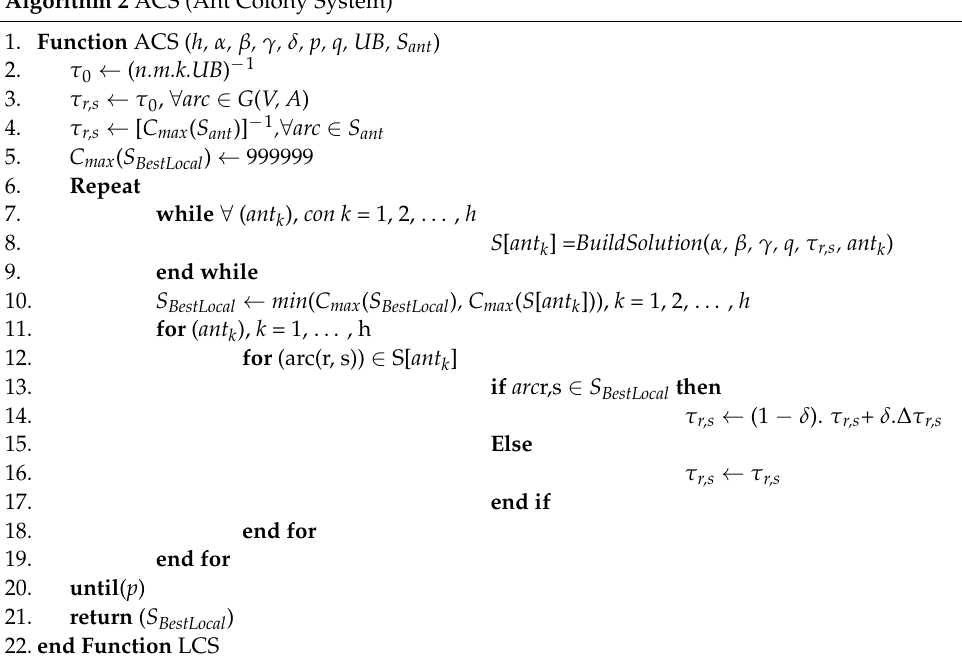
Algorithm 2 ACS (Ant Colony